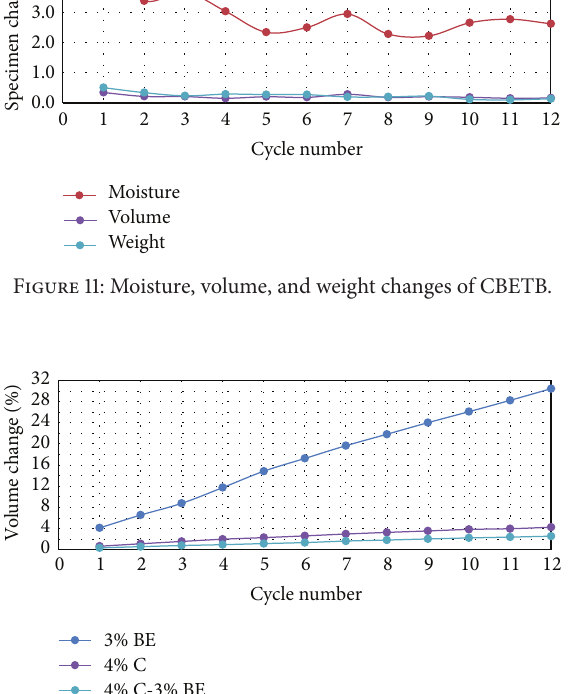
Figure 12: Total volume changes of BETB, CTB, and